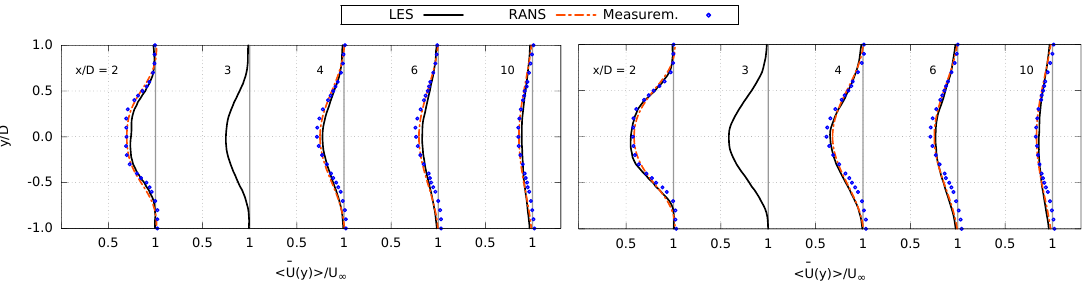
Figure 6. Vertical profiles of velocity deficit behind the disk C T = 0.45 ( left ) and C T = 0.71 ( right ), Ti12